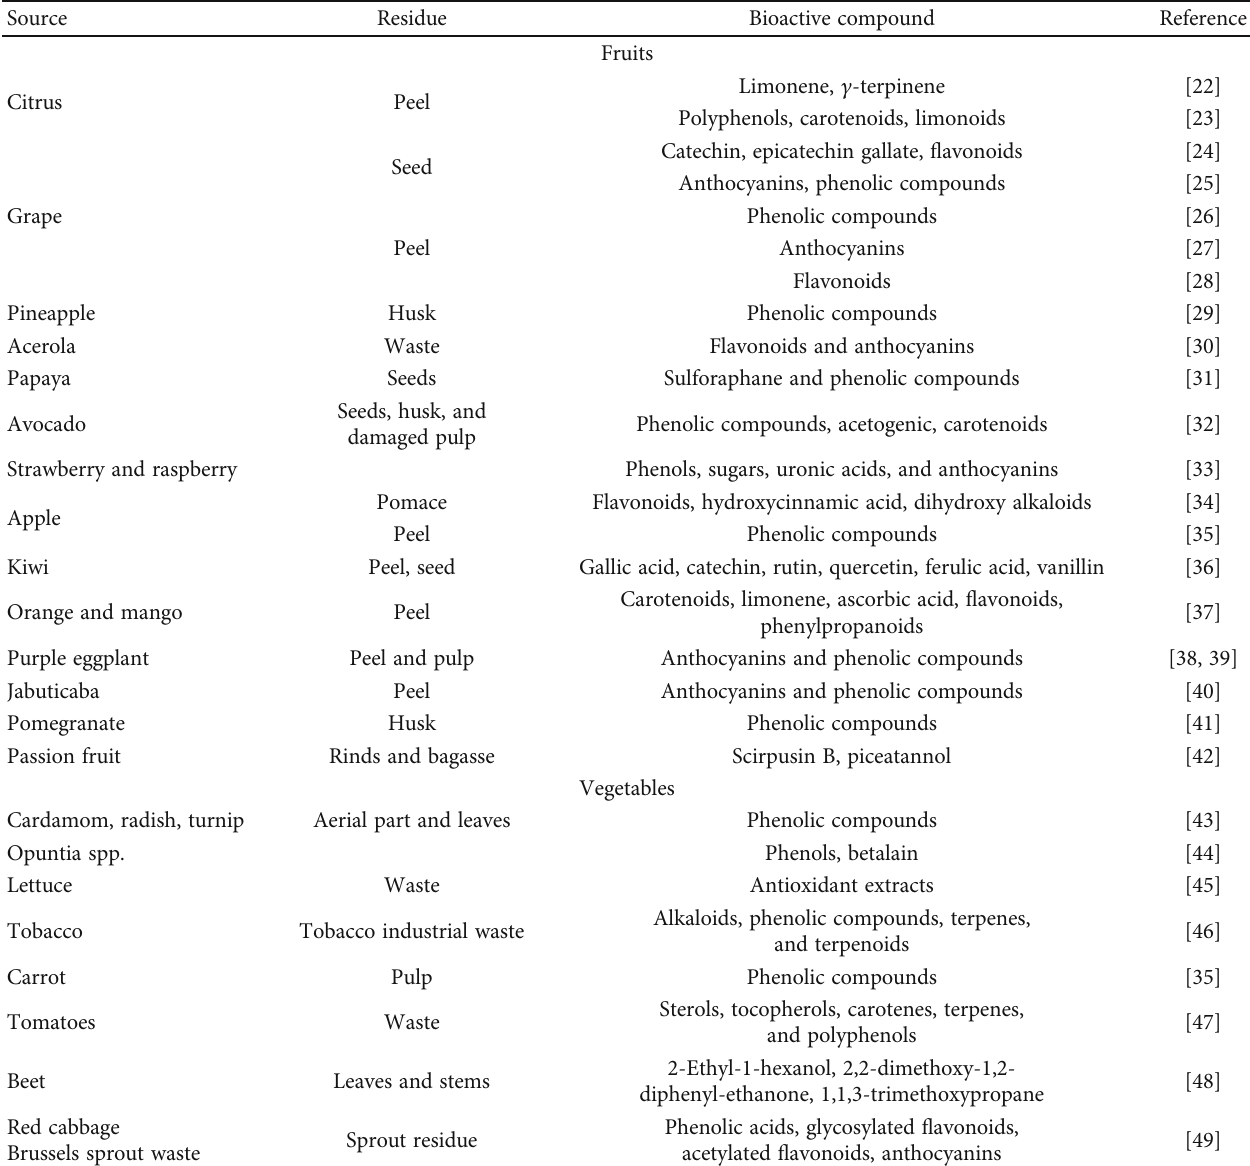
Table 1: Major bioactive compounds present in various plant